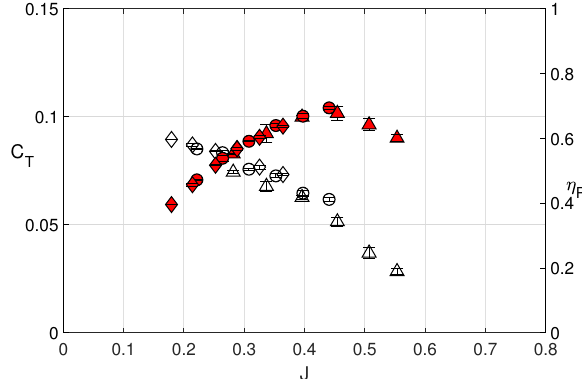
Figure 15. Plot of error on an 18 × 10 APC